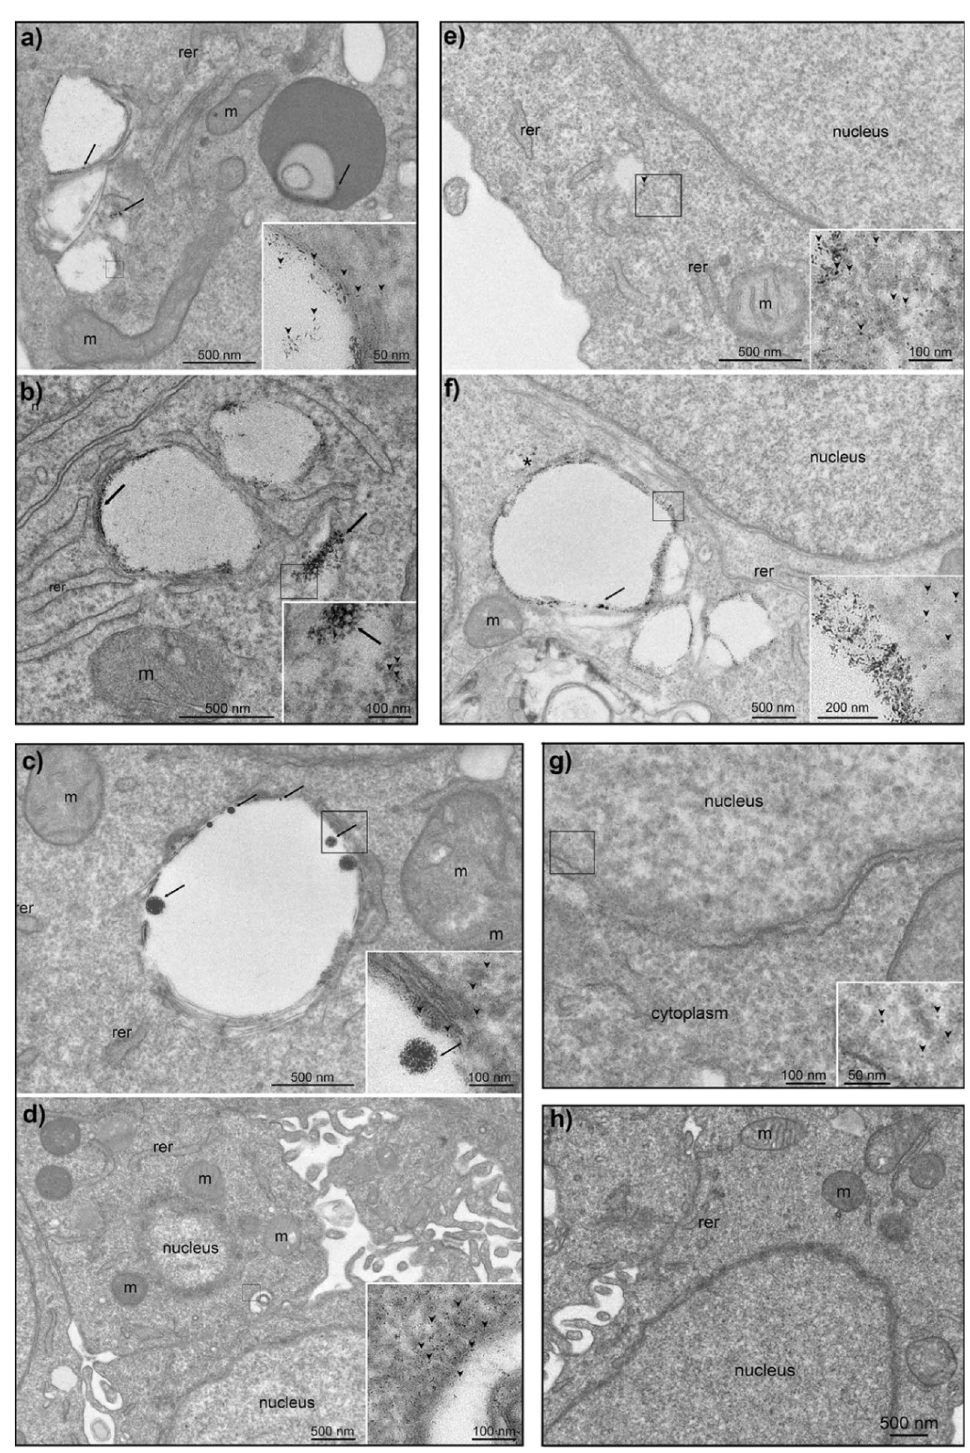
Figure 4. TEM micrographs of Hep G2 cells treated with aqueous suspensions of: a-G-AuNPs with the concentration of 70 µg/mL for 1 h ( a ) or 2 h ( b ); a-DG-AuNPs with the concentration of 70 µg/mL for 1 h ( c ) or 2 h ( d ); a-G-AuNPs ( e ) or a-DG-AuNPs ( f ) both with the concentration of 700 µg/mL for 1 h. Magnification of Hep G2 cells treated with a-G-AuNPs (70 µg/mL; for 1 h) evidencing the internalization of the AuNPs into the nucleus [black arrowheads in inset of ( g )]. Control experiment of Hep G2 cells not exposed to the nanoparticles ( h ). (m = mitochondria; rer = rough endoplasmic reticulum, n =